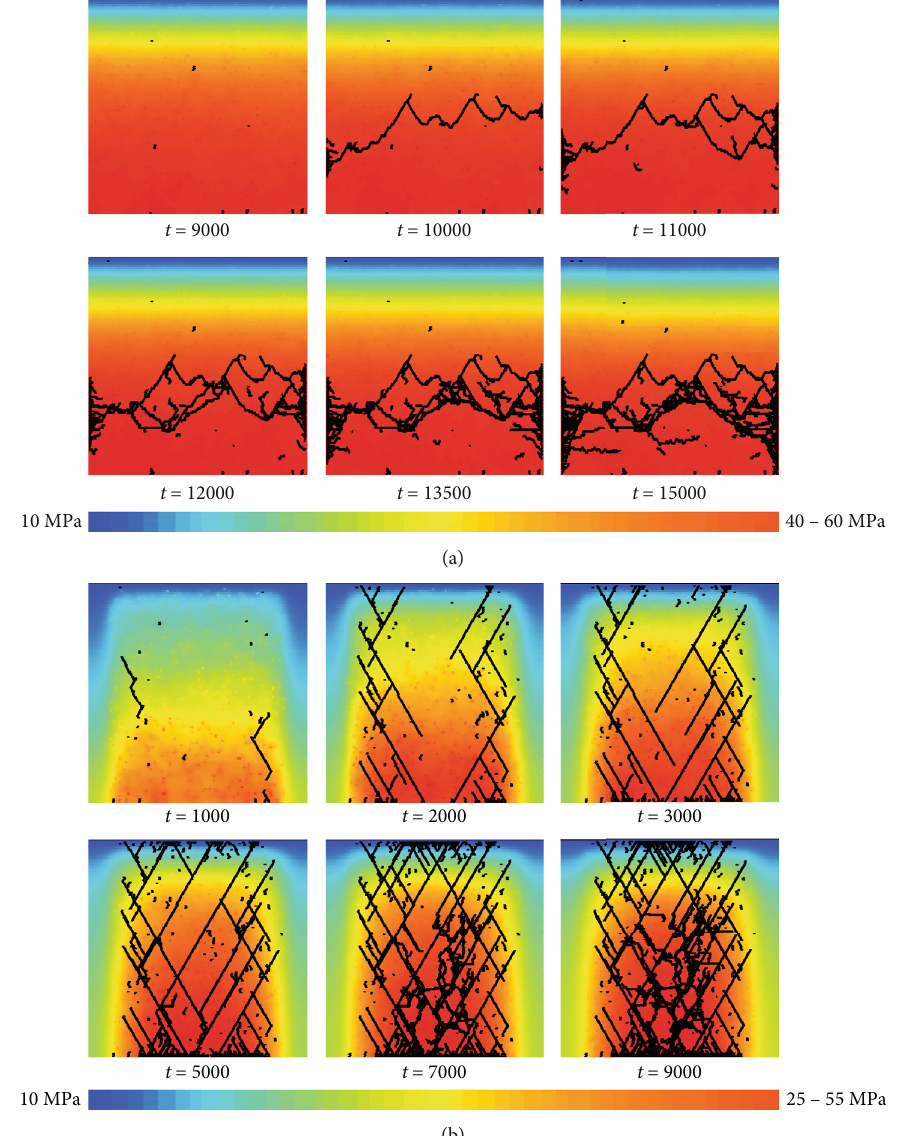
Figure 4: Time evolution of scenarios 1 and 2 (Figure 3) with the fl uid pressure color coded in the background and fractures in black. The fl uid pressure is rescaled for each picture. Time t is in days. (a) Scenario 1 builds fl uid pressure up until a single semihorizontal wavy fracture develops across the model. Successive fractures progress downwards and merge with existing ones to form a breccia-like pattern. (b) Scenario 2 develops a fi rst set of fractures early on at positions where the fl uid pressure gradients are steep. The fractures then progress inwards until after 5000 hours, an internal fracture pattern develops that forms tree-like branches and